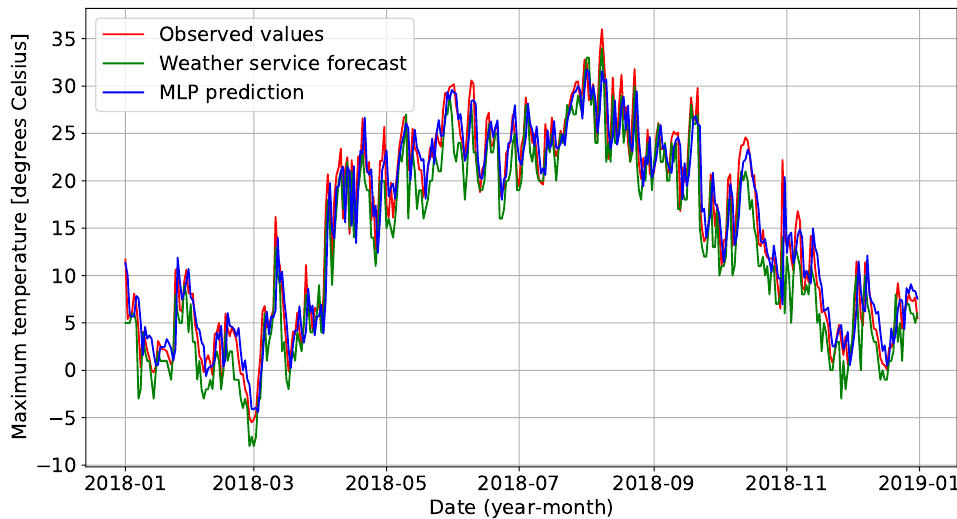
Figure 3. Comparison between the observed values and those predicted by the MLP and weather service maximum